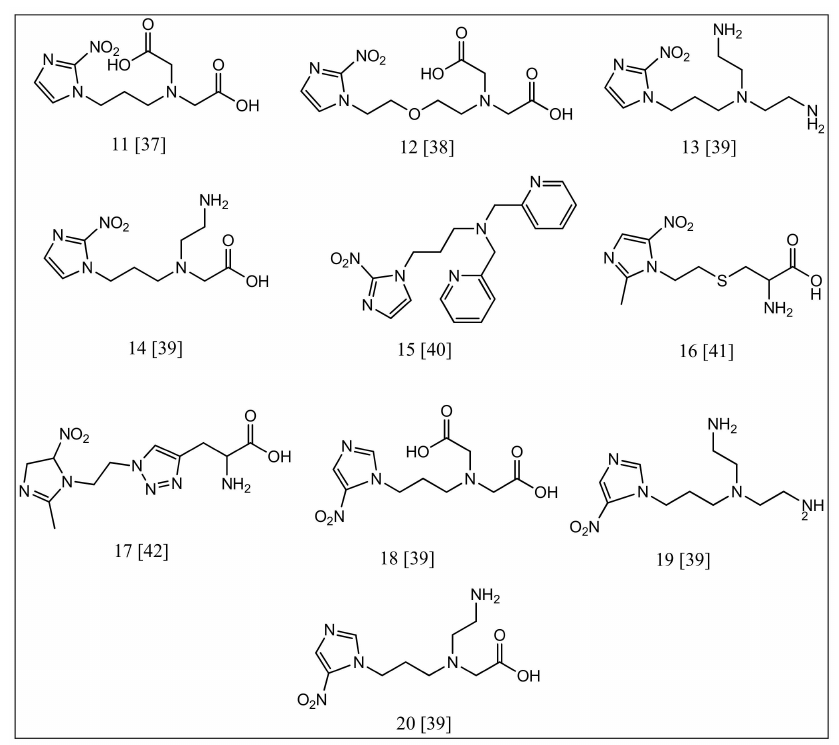
Figure 5. Structure of imidazole derivatives used in the preparation of [ 99m Tc]Tc-tricarbonyl complexes